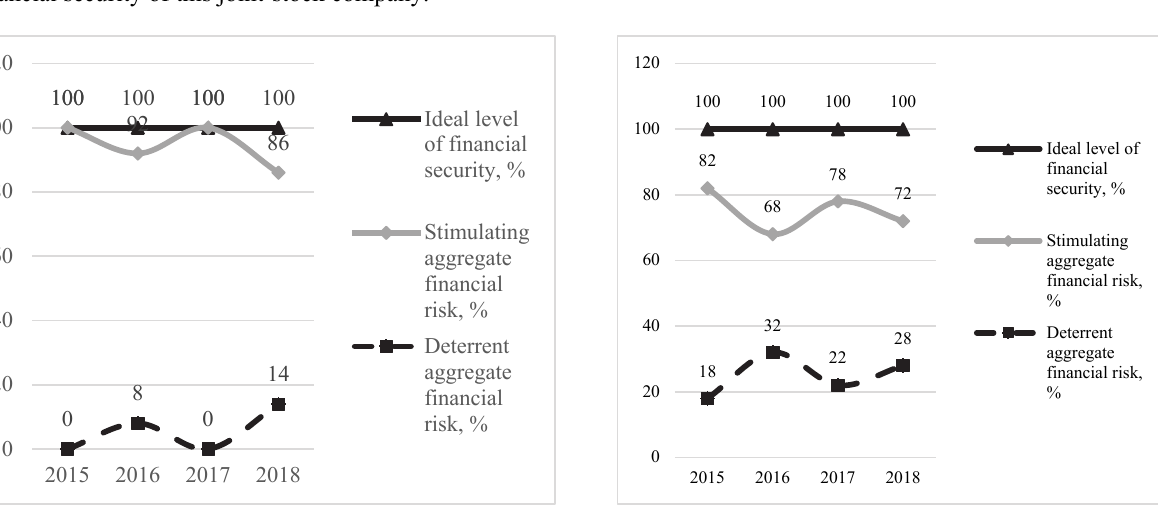
Fig. 6. Impact of restraining financial risk on the financial security level of PJSC “Turboatom” in 2015-2018, %*